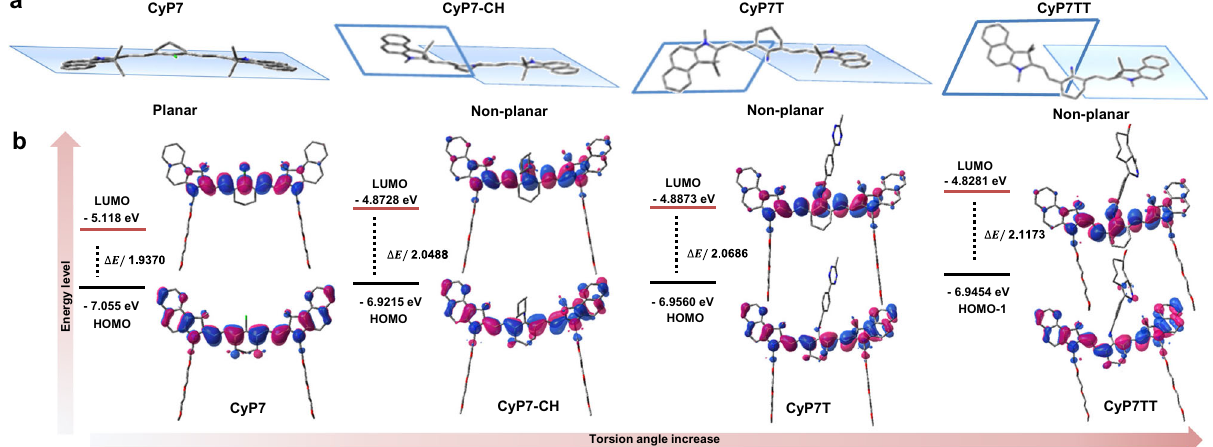
Fig. 3 Mechanism for TIDA effect under theoretical calculations. a Representative molecular structures and conformations of CyP7, CyP7-CH, CyP7T, and CyP7TT cyanines optimized at B3LYP/6-31G* level (hydrogen atoms, N-substituents on benzoindole rings and meso-amino-substituents are neglected for clear vision). b HOMO/HOMO-1/LUMO orbitals and energies with the largest oscillator strengths for CyP7, CyP7-CH, CyP7T, and CyP7TT (hydrogen atoms are